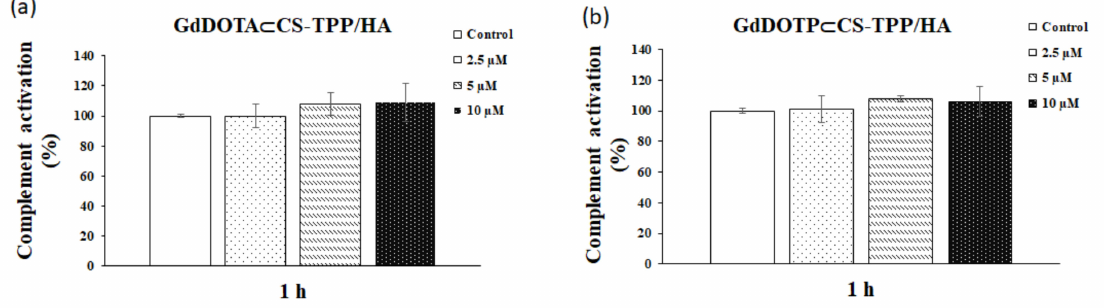
Figure 4. Classical activation of the complement system after 1 h of exposure to doses of 2.5, 5 and 10 µ M of ( a ) GdDOTA ⊂ CS-TPP/HA and ( b ) GdDOTP ⊂ CS-TPP/HA NGs. A human serum sample incubated at 37 ◦ C served as a negative (normal) control. Data are expressed as mean ± SD ( n = 3).